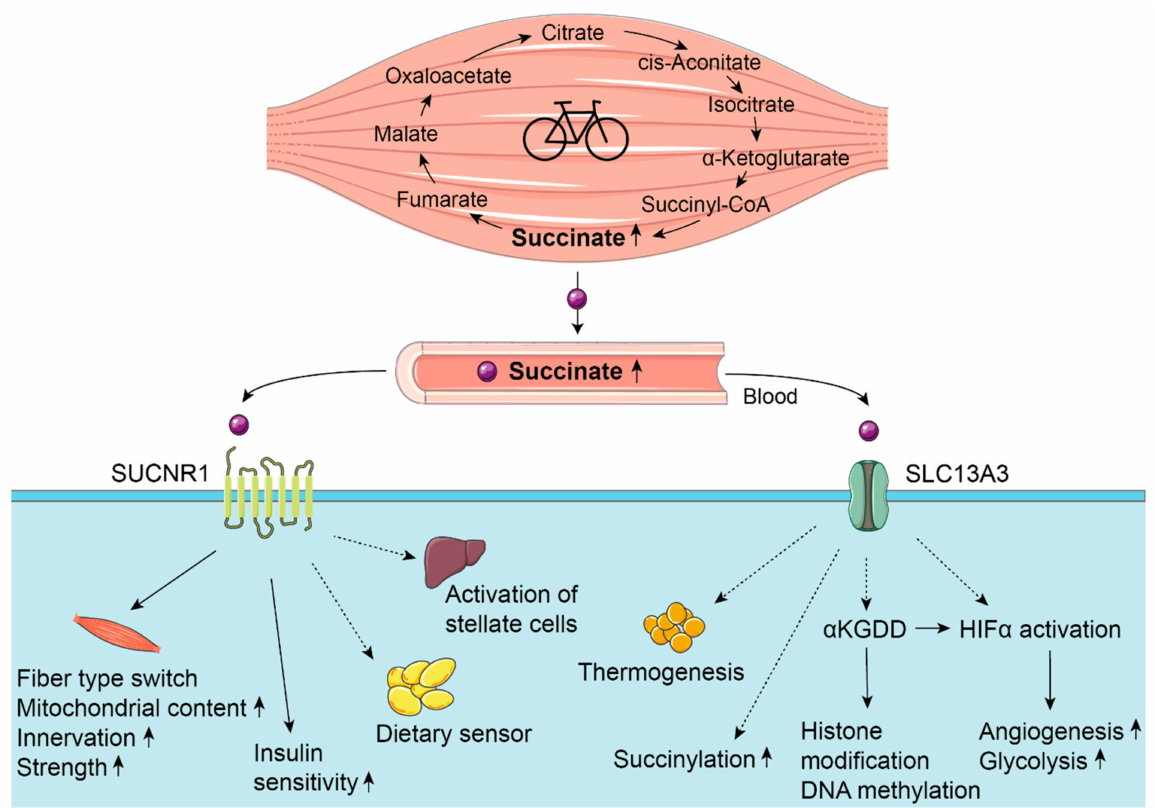
Figure 3. Action of succinate as a myometabokine. Skeletal muscle releases succinate during exercise, resulting in elevated plasma levels. Succinate then mediates signaling on target organs by either binding to its specific cell surface receptor SUCNR1 or after cellular uptake via SLC13A3. Solid arrows: succinate-mediated effect in exercise adaptation has been shown; dashed arrows: signaling function not studied in the context of exercise to date. The figure was created using Servier Medical Art templates, which are licensed under a Creative Commons Attribution 3.0 Unported License; https://smart.servier.com (accessed on 22 June